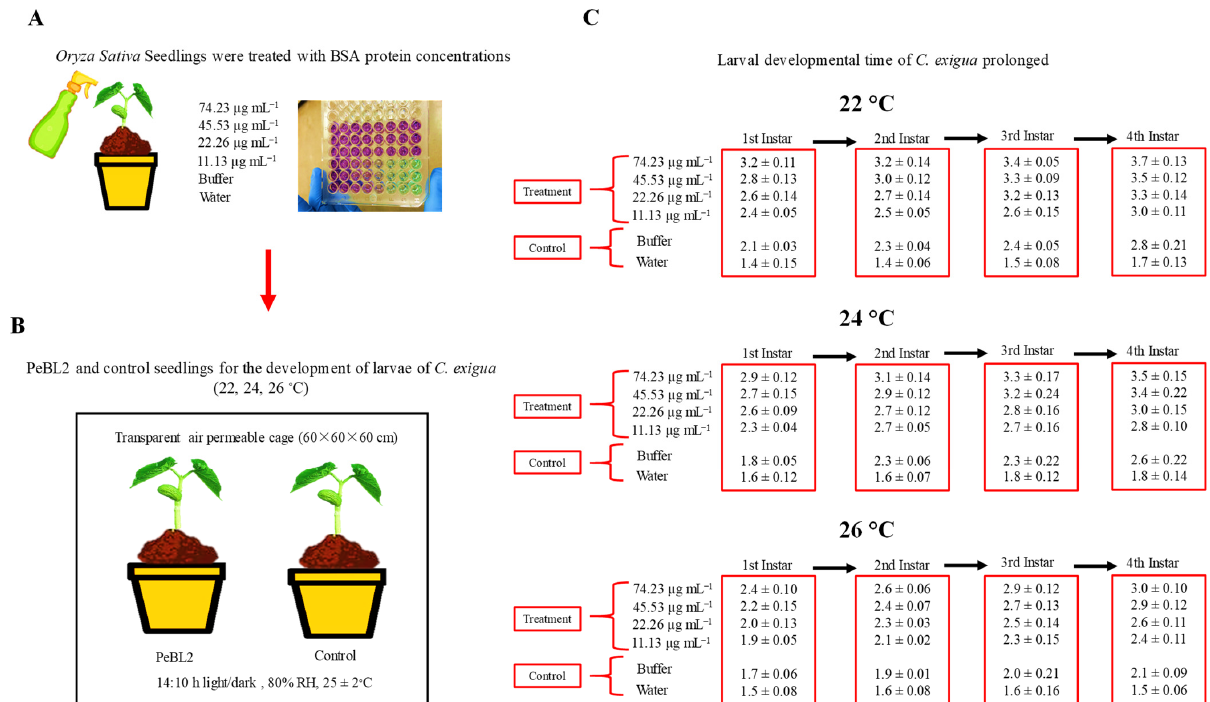
Figure 4. Prolonged larval development time of C. exigua instars (1st, 2nd, 3rd, and 4th). ( A , B ) Oryza sativa seedlings treated with control, buffer, and four PeBL2 protein concentrations prepared by BSA. ( C ) Larval developmental time of C. exigua from the prolonged 1st to 4th instar’s in PeBL2-treated O. sativa seedlings. Data are shown as the (mean ± SE) of different larval instars of ( C. exigua ) on O. sativa plants by the PeBL2 elicitor protein at different concentrations and different temperature regimes ( n = 10). Data were compared statistically by a factorial ANOVA and LSD at α = 0.05 in Statistix, version 8.1.